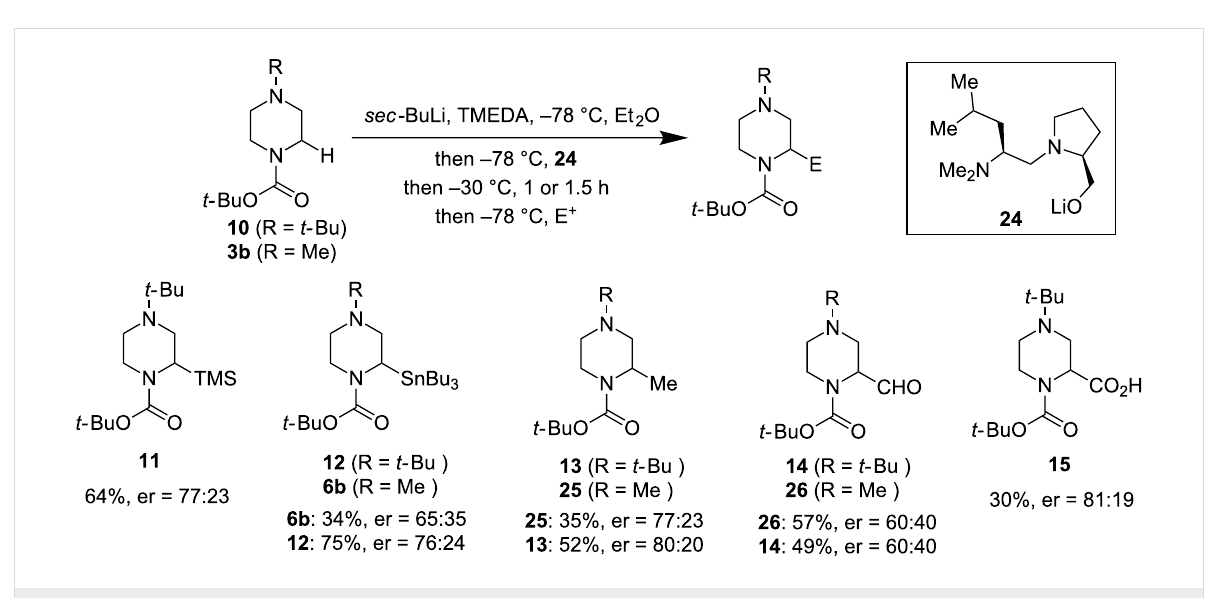
Figure 7: Dynamic thermodynamic resolution of lithiated of N -Boc-piperazines by Coldham et al. in 2010